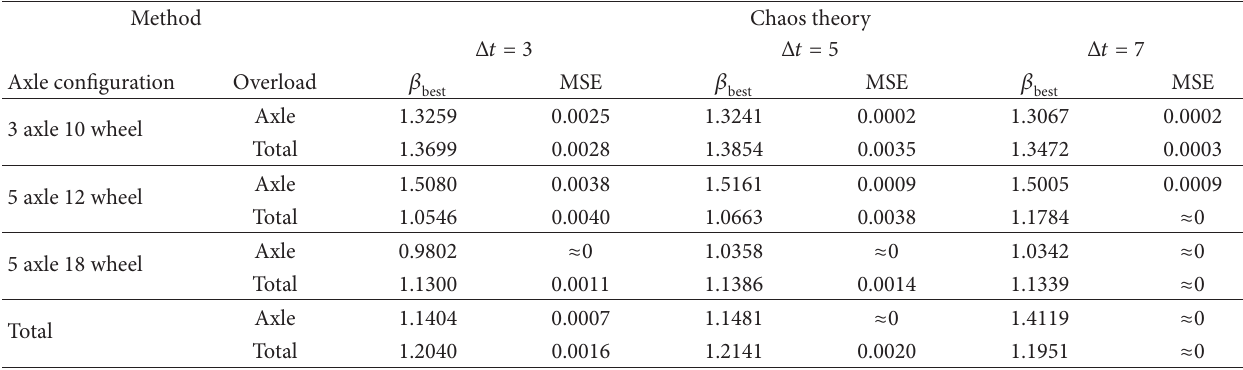
T 3: Coefficients and mean square errors in chaos theory.